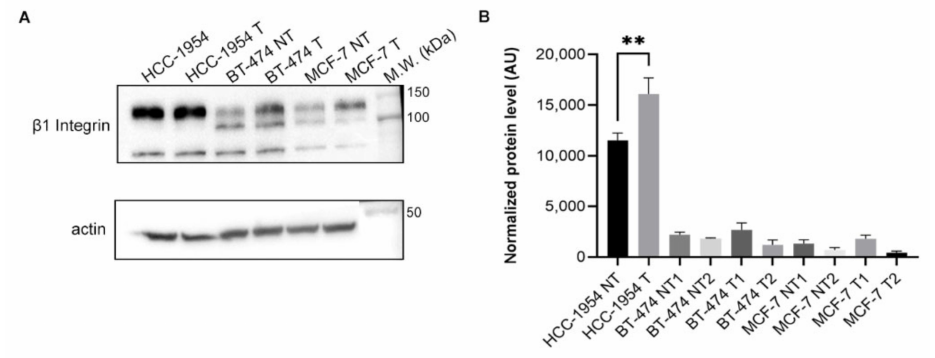
Figure 5. β 1 Integrin expression in the HCC-1954, BT-474, and MCF-7 cell lines treated (T) or not treated (NT) with trastuzumab. ( A ) Western blot of β 1 integrin showing different expression levels in HCC-1954, BT-474, and MCF-7 cell lines in not-treated (NT) and treated (T) with 20 µ g/mL of trastuzumab for 72 h. ( B ) Western blot quantification of β 1 integrin in three independent experiments. Bar chart shows quantification of protein levels compared to the control in each condition. Actin was used as the load control. Error bars show standard deviation, ** p < 0.01. Raw data of Western blot membrane are shown in Supplementary Figure S9C.